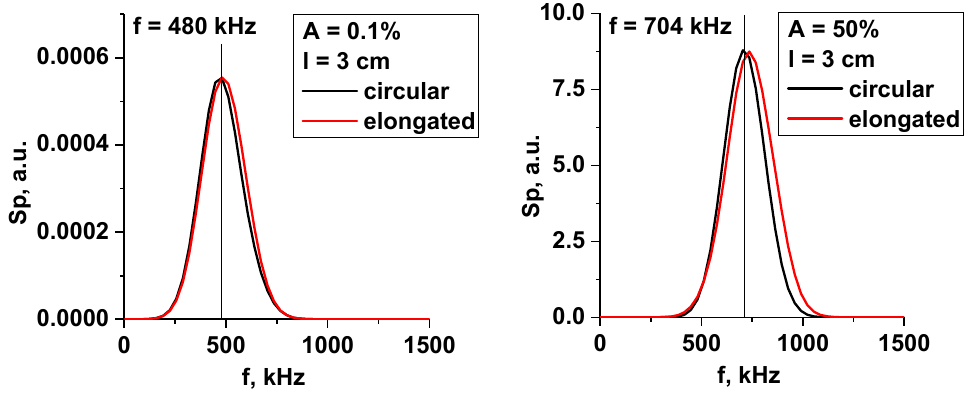
Figure 26. Spectrum of the DBS signals for the 3 cm filament: ( left ) filament amplitude of 0.1% of density at cutoff of the probing wave 48 GHz where the filament was positioned; ( right ) filament amplitude of 50%. The black lines correspond to the circular filament, and the red lines correspond to the radially stretched filament.